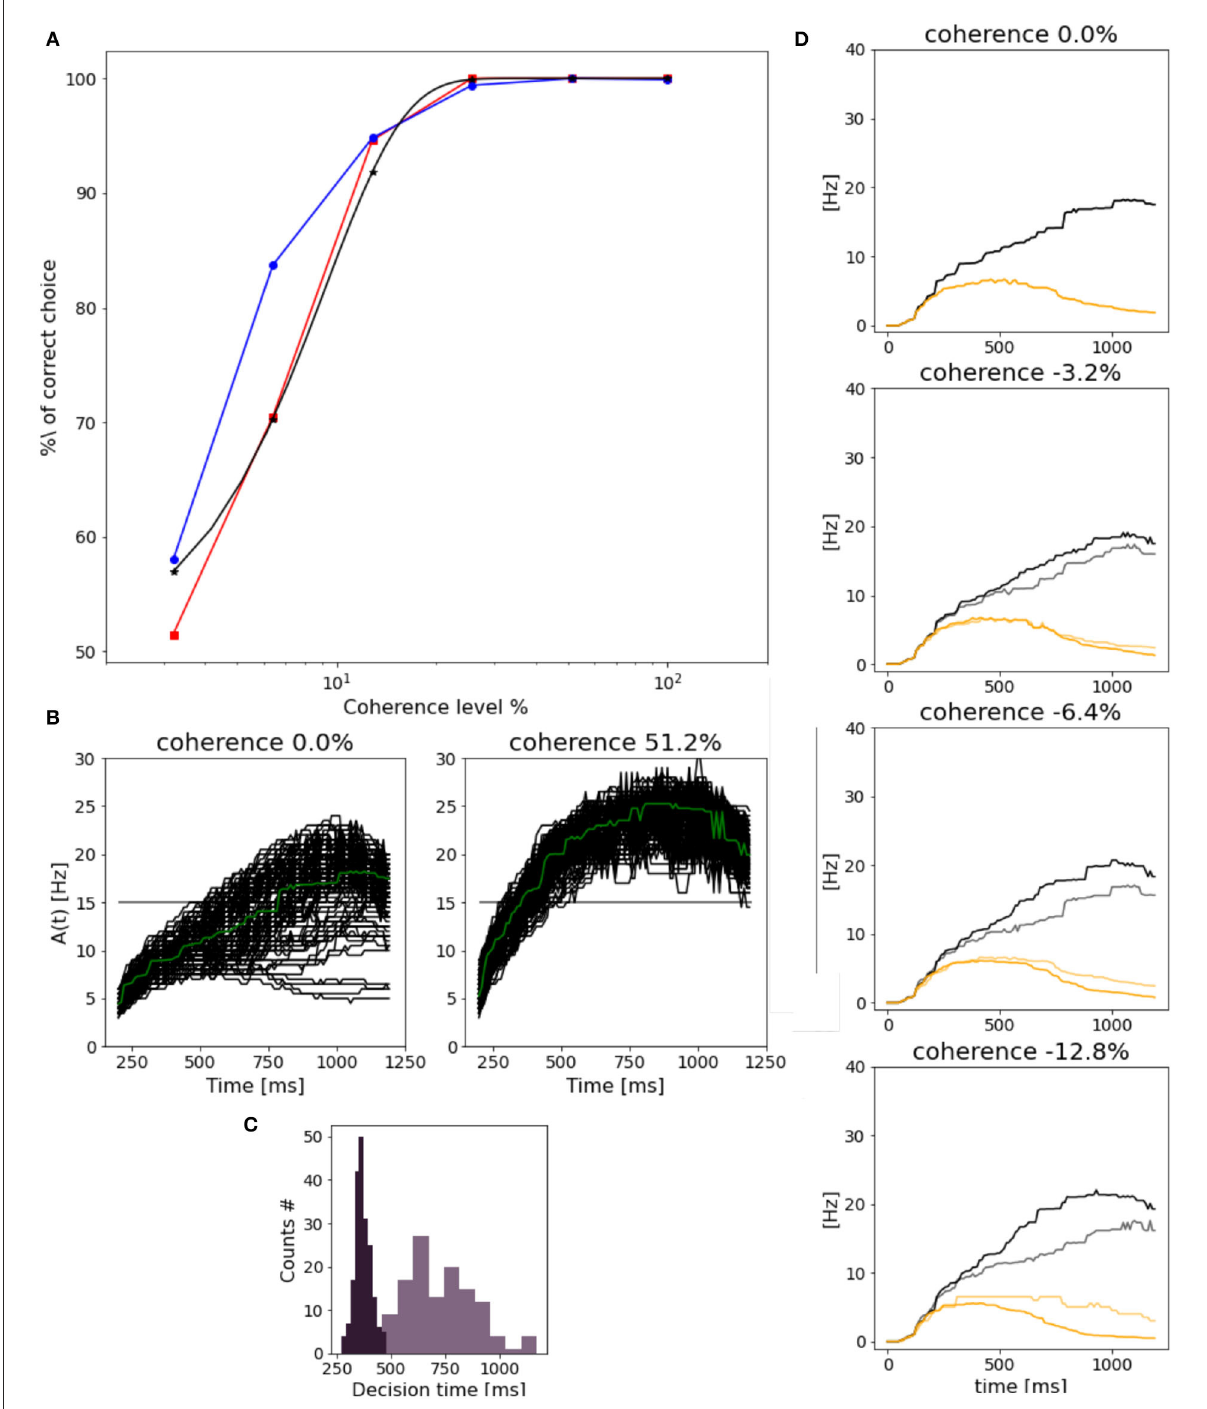
FIGURE7 Network performance and reaction time: (A) Neurometric function reported as the percentage of the correct choice. In blue for population B, in red for population A and in black the weibull fit as reported by Wang (2002). (B) Response of population B (median filter applied to the original trace) in trials with 0.0% (left) and 51.2% (right) stimulus coherence. Green line represents the mean along trials. (C) Dark purple plot is the decision time histogram for trials where the network was stimulated with 51.2% coherence. Light purple histogram, for trials with 0.0% coherence level. (D) Evolution of population B response for four different coherence levels. Black curves (correct trials): population B wins over A and the stimulus is in the preferred direction for population B. Gray curves (error trials): population B wins but the stimulus is the non-preferred direction for population B. Orange curves (correct trials) population B loses over A, and a non-preferred stimulus for B is delivered. Light orange (error trials) population B loses over A, even if the stimulus was in the preferred direction for